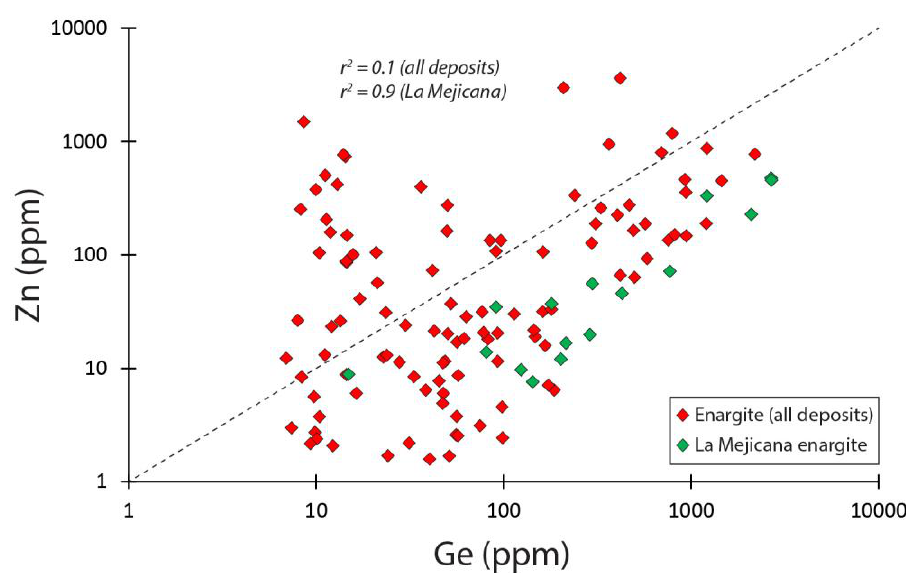
Figure 9. Correlation plot of Zn vs. Ge in enargite from all deposits included in this study (red diamonds), based on LA-ICP-MS spot data. Enargite from La Mejicana (highlighted in green) show a particularly strong correlation between Zn and Ge, however, the concentrations of Zn are consistently lower than those of Ge (below the 1:1 correlation line).